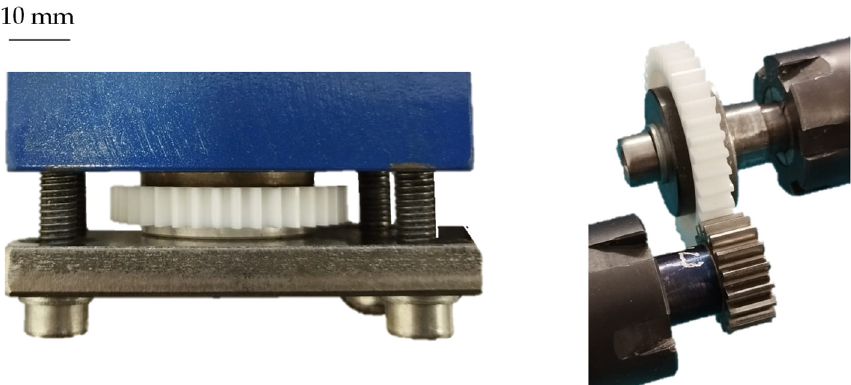
Figure 5. Clamping of the plastic gears, pulsator tests ( left ) and gear test runs ( right ).